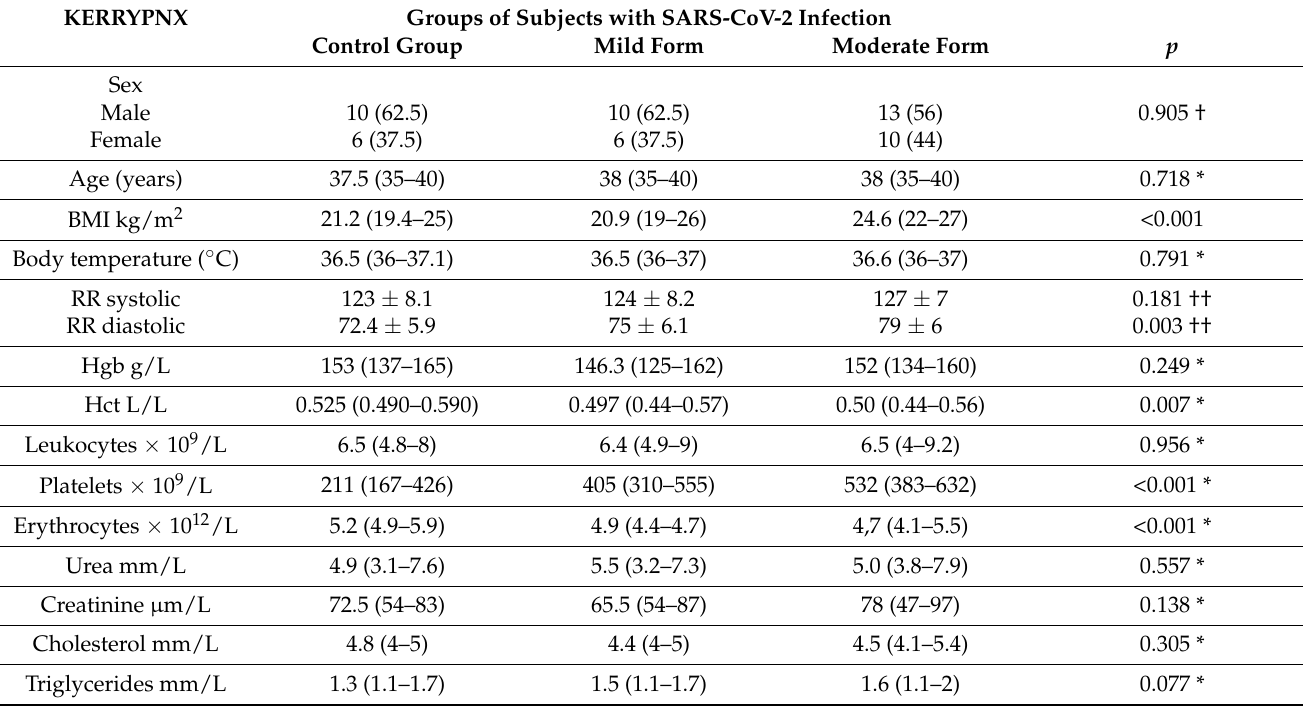
Table 3. Display of the number of subjects (%) according to qualitative variables and median (min–max) or arithmetic mean ± SD of quantitative variables in relation to the examined groups (control group, groups with moderate and mild form of SARS-CoV-2 infection).